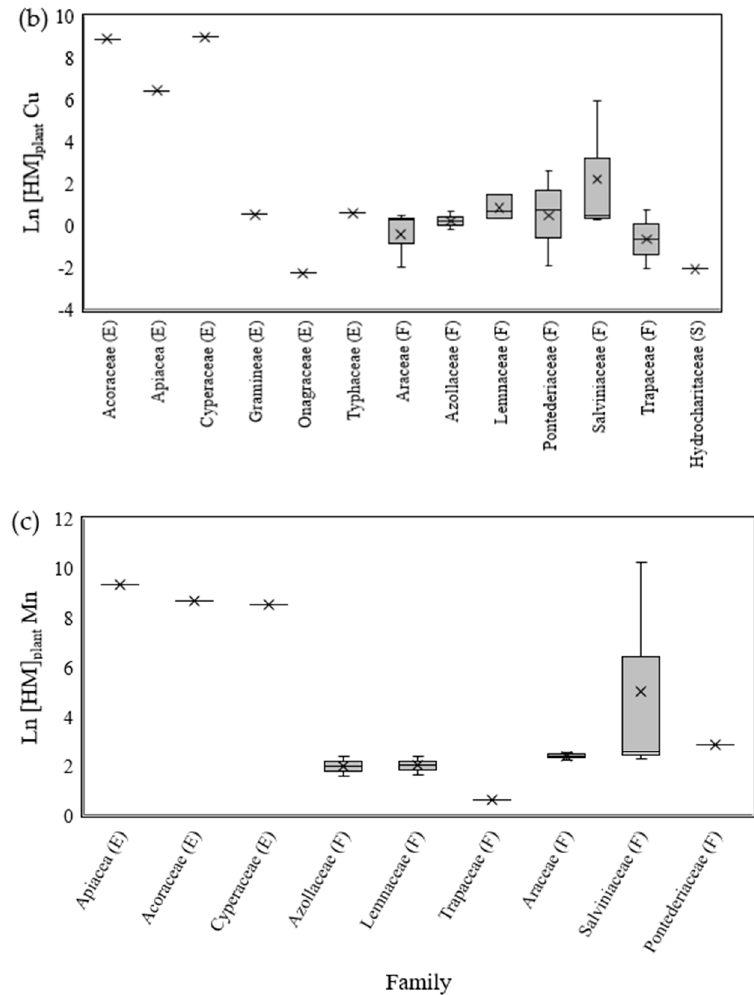
Figure 2. Boxplot of the concentrations of HMs in plant tissues, expressed in ln, for iron ( a ), copper ( b ) and manganese ( c ). The symbol “X” represents the average. (E) Emergent families of macrophyte. (F) Floating families of macrophyte. (S) Submerged families of macrophyte.